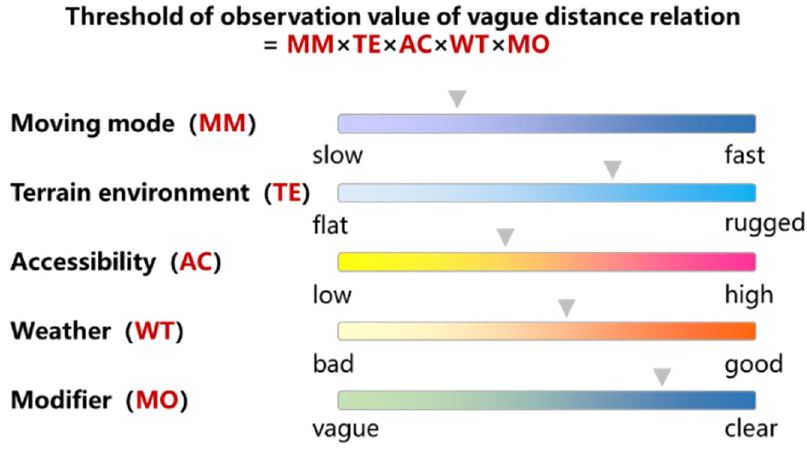
Figure 4. Threshold of observations of vague distance relation.